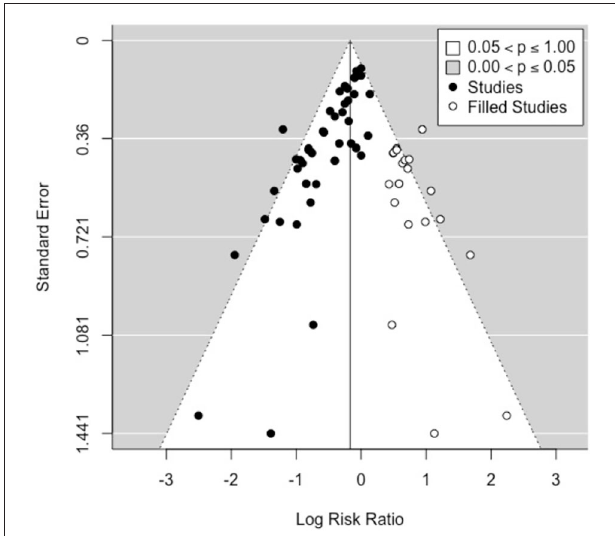
FIGURE 4 | Funnel plot showing the 21 studies (open circles, on the right side) imputed by the trim-and-fill method to carry out a sensitivity analysis for publication